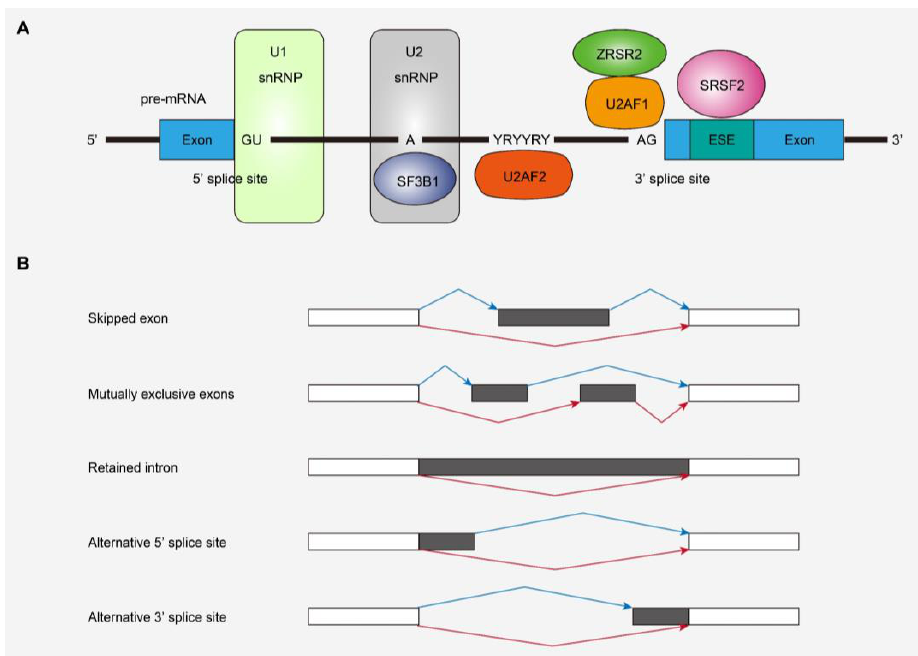
Figure 2. Splicing factors (SFs) and alternative splicing affected by mutations. ( A ) SFs frequently affected in myeloid malignancies and their functions in RNA splicing. ( B ) Types of alternative splicing events detected in SF-mutated leukemias. snRNP, small nuclear ribonucleoprotein; ESE, exonic splicing enhancer.